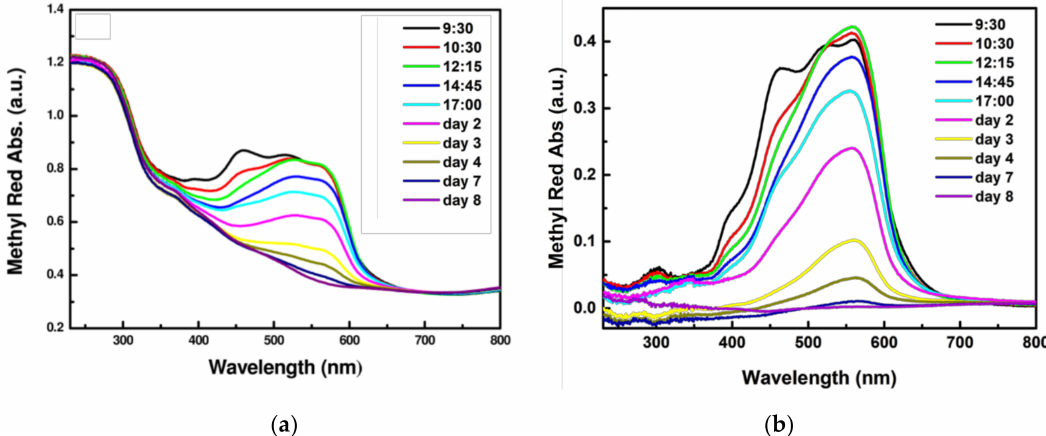
Figure 10. ( a ) The reflectance spectra of the sample PL-D during the outdoor photocatalysis experiment without the baseline, showing that the signal related to the presence of TiO 2 coating did not change during the experiment. The spectra were recorded at 9:30 (before outdoor exposure), 10:30, 12:15, 14:45, and 17:00 during the first day of outdoor exposure and were performed every 24 h in the subsequent 6 days. ( b ) The reflectance spectra recorded at subsequent time intervals during the outdoor photocatalysis experiment, using the trace of the same sample before dye deposition as the baseline. The spectra were recorded at the 9:30, 10:30, 12:15, 14:45, and 17:00 during the first day of outdoor exposure, and were performed every 24 h in the subsequent 6